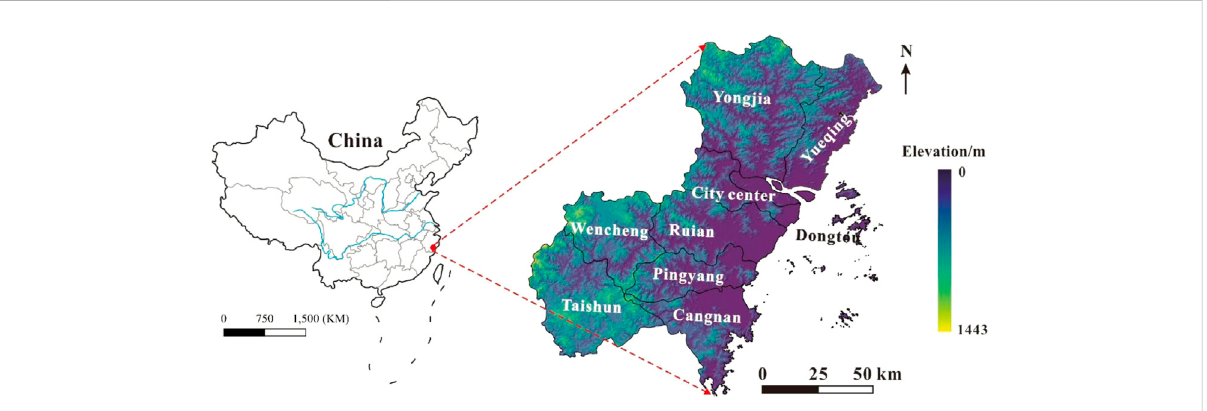
FIGURE 1 LocationofthestudyareawherethebasemapistheDEMoftheregionwith30-mresolutionandshowsthedistributionofadministrationareas.